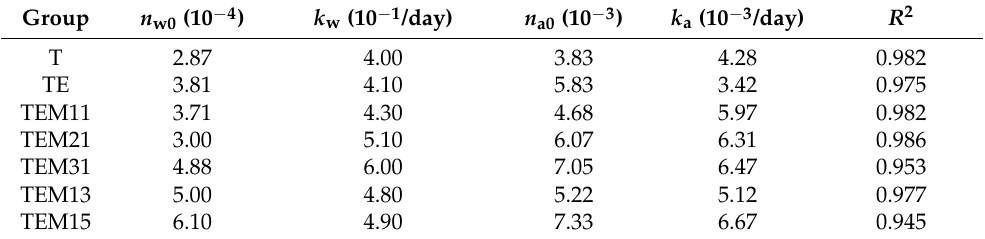
Table 7. Kinetics of cellulose degradation parameters in OIP under simultaneous multi-stress aging [19].